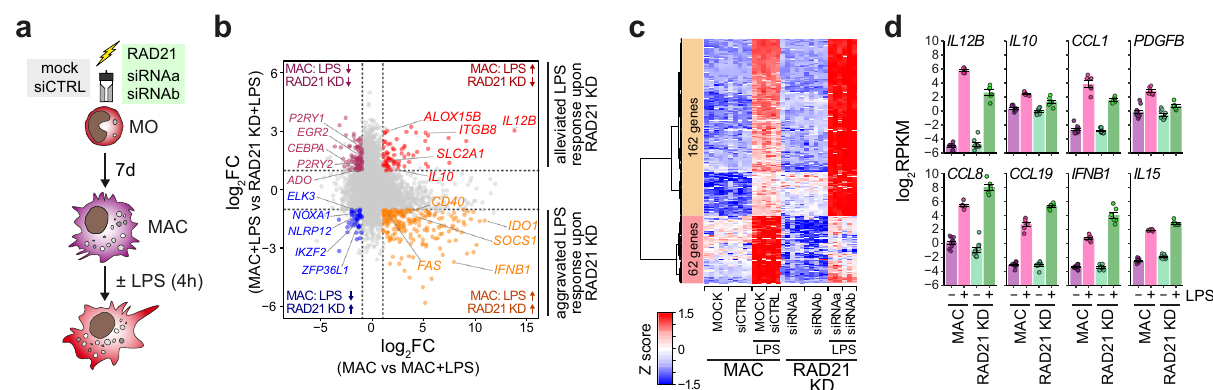
Fig. 9 Loss of cohesin alters innate activation programs in MAC. a Schematic of the experimental setup. MO were either mock-treated or electroporated with control siRNA (siCTRL) or either of the two speci fi c RAD21 targeting siRNAs and cultured in MAC culture conditions. MAC were activated with LPS for 4 h on day 7. a Scatter plot of genes differentially expressed in control versus RAD21 knockdown MAC upon LPS stimulation. Genes were categorized for their response to LPS in control MAC (x-axis) and for the effect of RAD21 KD after LPS stimulation (y-axis). Colored genes showed at least two-fold difference in their expression (FDR < 0.05) in both comparisons, as indicated in the corners of the plot. Exemplary genes are highlighted. c Heatmap presenting scaled expression data of differentially LPS-induced genes (FC > 2, CPM > 1, FDR < 0.05, quasi-likelihood (QL) F-test for 1.5-fold difference) between control- (MOCK & siCTRL) and RAD21 KD cells. Independent replicates per condition: unstimulated cells, n = 5; LPS-treated cells, n = 3. d Bar plots showing expression levels examples of genes differentially activated upon RAD21 KD (mean normalized RPKM ± SE based on the RNA-seq data; controls: n = 10 samples from fi ve donors; LPS-treated: n = 6 samples from three donors). All examples were signi fi cantly induced upon LPS treatment in MAC (FDR < 0,05, QLF-test for 1.5-fold difference) and showed signi fi cant differences in their expression between LPS-stimulated control and RAD21 KD MAC (FDR < 0,05, QLF-test for 1.5-fold difference). ( b – d ) Source data are provided as a Source Data fi